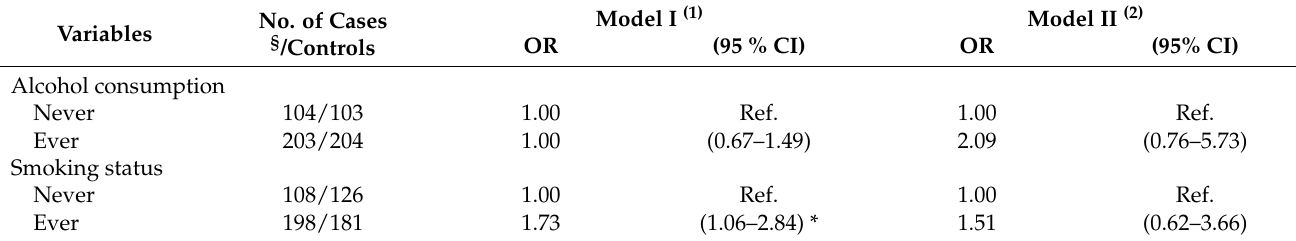
Table 2. Odds ratios of gastric cancer by alcohol consumption or smoking